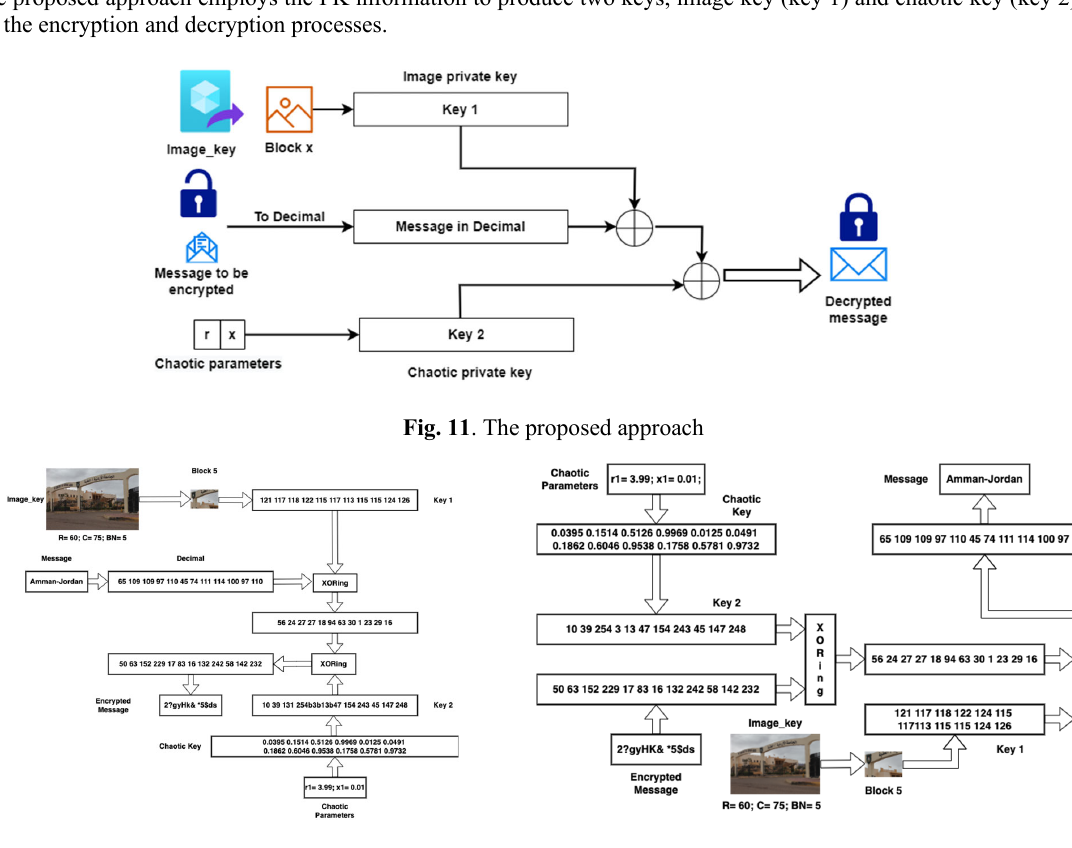
Fig. 12. Encryption phase example Fig. 13. Decryption phase